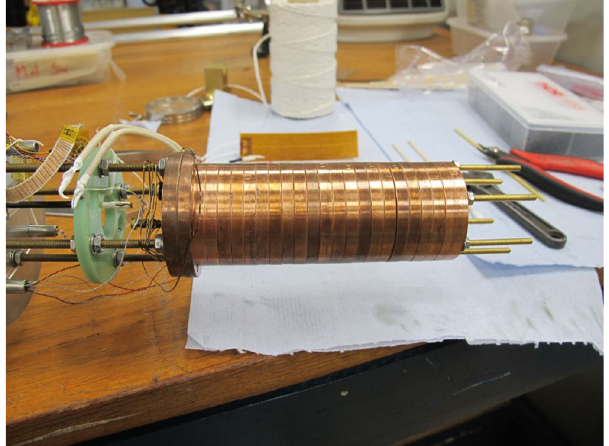
FIG. 2. Experimental setup. The 5-mm-thick copper holders, in which the 4-mm-thick HTS bulks are placed, are stacked on the end of the measurement system with a temperature sensor. This is installed into the cryostat with the 12-T solenoid.